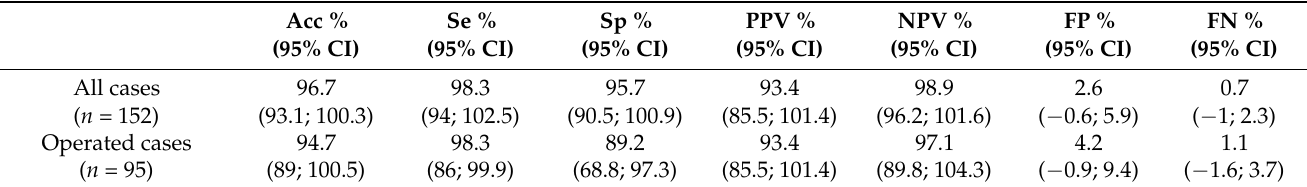
Table 2. Diagnostic value of US in all patients and operated cases.